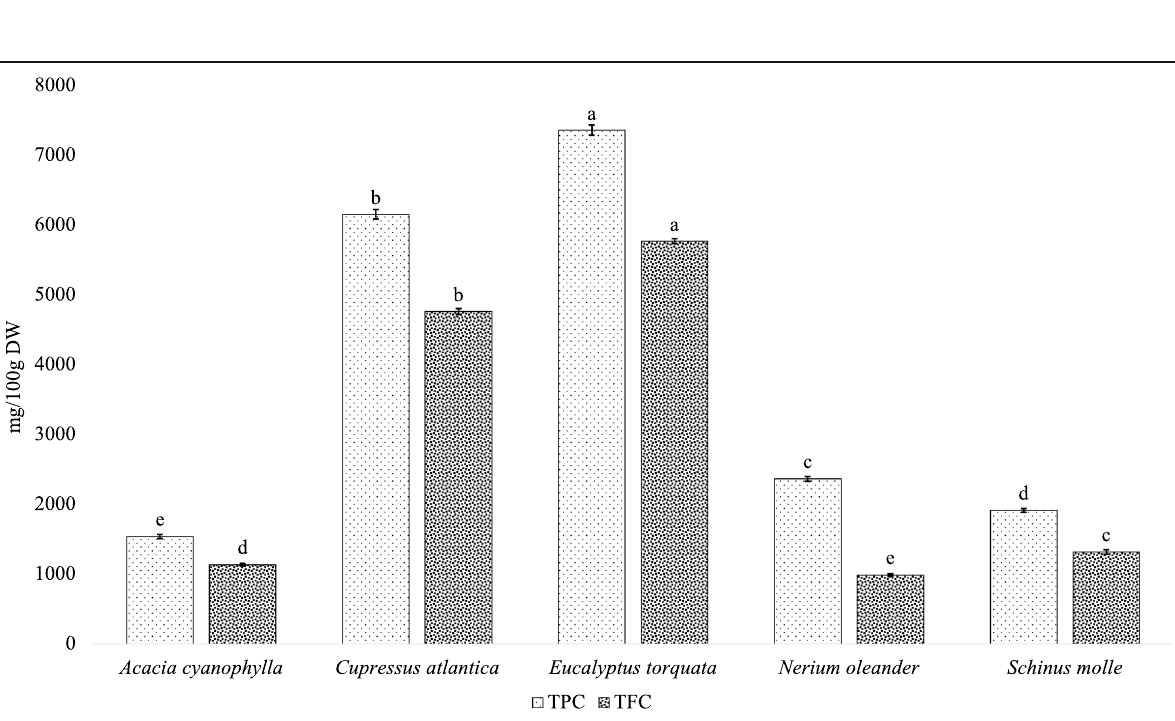
Fig. 4 Total polyphenols (TPC) and flavonoids (TFC) content in plant extracts. Plant species had significant effects on TPC and TFC (one-way ANOVA, p < 0.05). Each bar represents the mean of four replicate measurements. Within each secondary metabolite group (TPC or TFC), different letters above bars indicate significant differences among plant species (Bonferroni tests, p < 0.05). Error bars represent standard errors